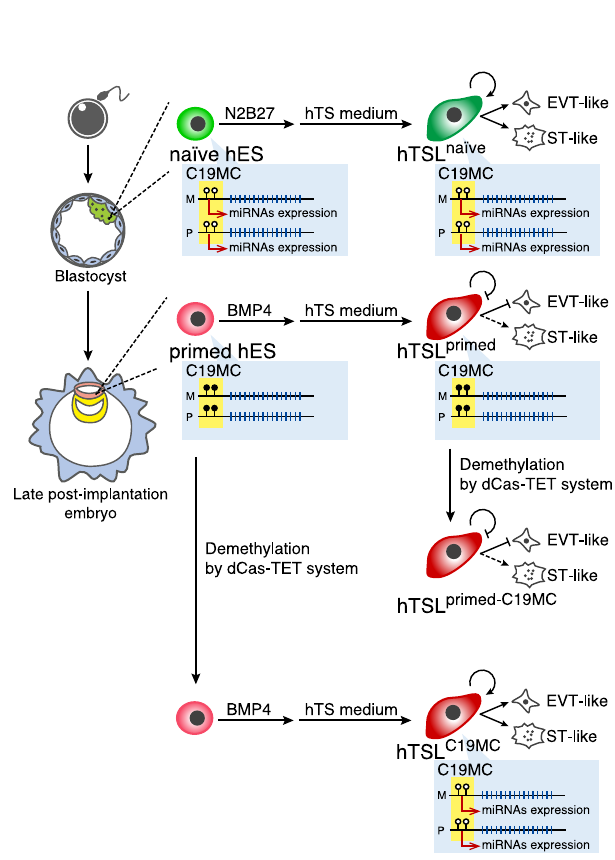
Fig. 6 Summary of the derivation and characterization of hTSL cells. Both alleles of the C19MC DMR are hypomethylated in naïve hES and hTSL naïve cells, but hypermethylated in primed hES and hTSL primed cells. The C19MC DMR is demethylated in hTSL C19MC and hTSL primed-C19MC cells using the dCas-TET system. Although hTSL naïve and hTSL C19MC cells are highly proliferative and can differentiate into both EVT- and ST- like cells, hTSL primed and hTSL primed-C19MC cells have poor proliferation and differentiation potentials. The C19MC DMR is highlighted in yellow. Black and white circles indicate methylated and unmethylated CpGs, respectively. M: maternal allele, P: paternal